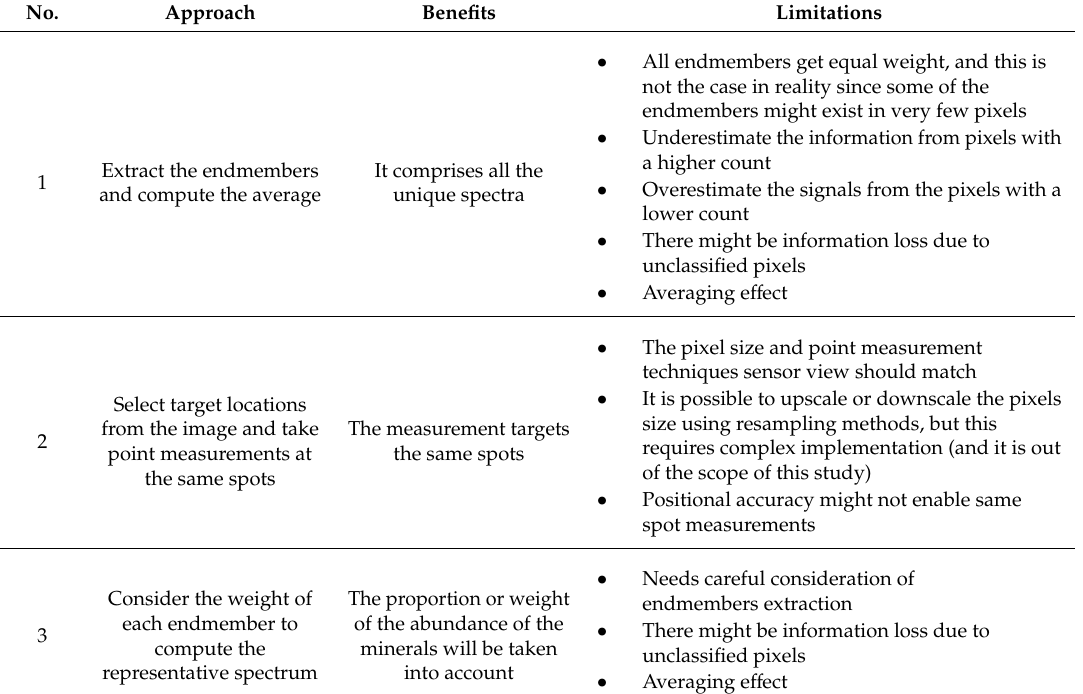
Table 1. Evaluation of some of the possible hyperspectral image and point spectroscopic data fusion